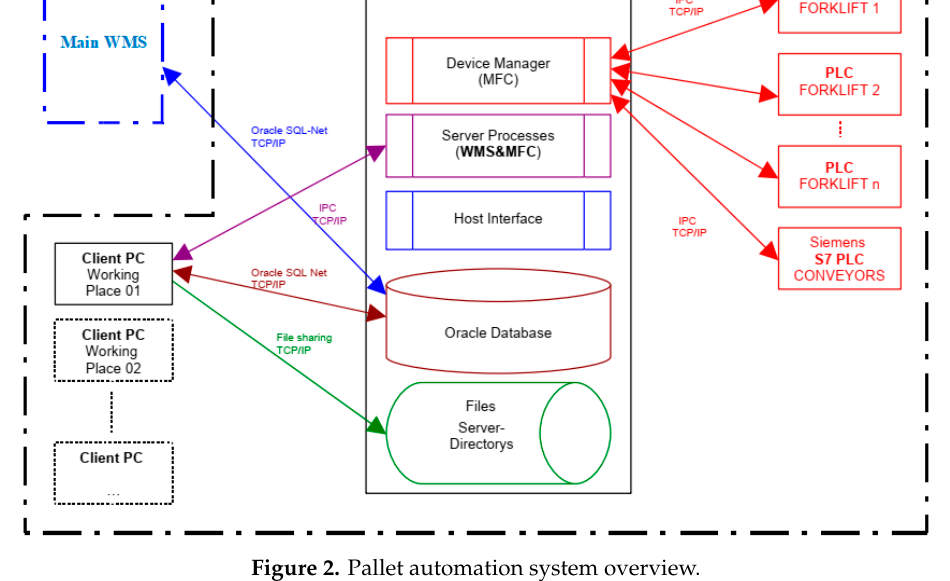
Figure 2. Pallet automation system overview.